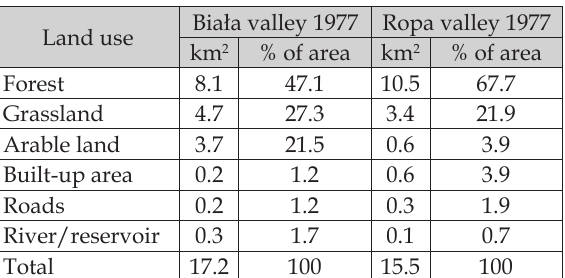
Table 1. land use in the tested area of the Biała and Ropa valley in 1977.